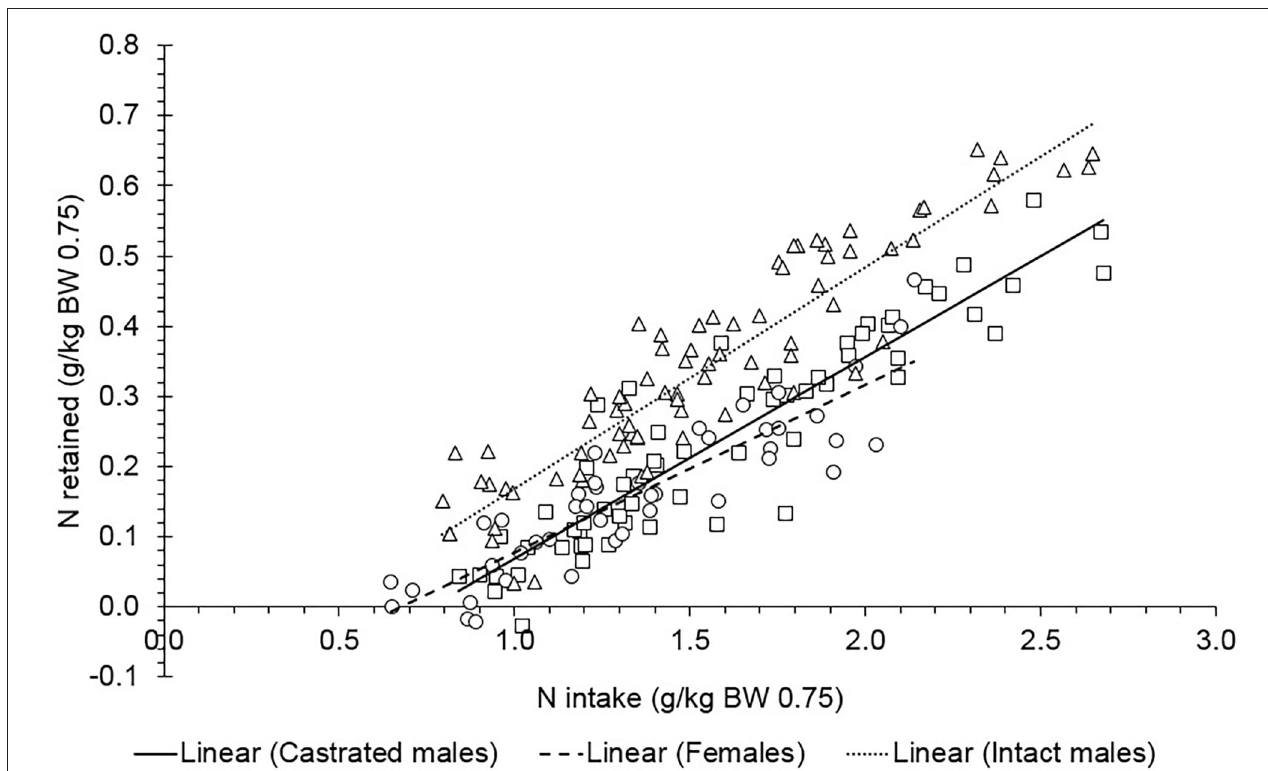
FIGURE 3 | Relationship between daily protein retained (g/kg 0.75 BW) and daily metabolizable protein (MP) intake (g/kg 0.75 BW) of Saanen goats of different sexes. For all animals: protein retained = − 1.98 ( ± 0.154) + 0.525 ( ± 0.0220) × MPI. The estimated block nested to study variances ( σ 2 b : s ) and the residual variances ( σ 2 e ) were 0.0891 and 0.212, respectively. The parameters of the equation did not differ between sexes ( P = 0.55). The observations were adjusted for the study